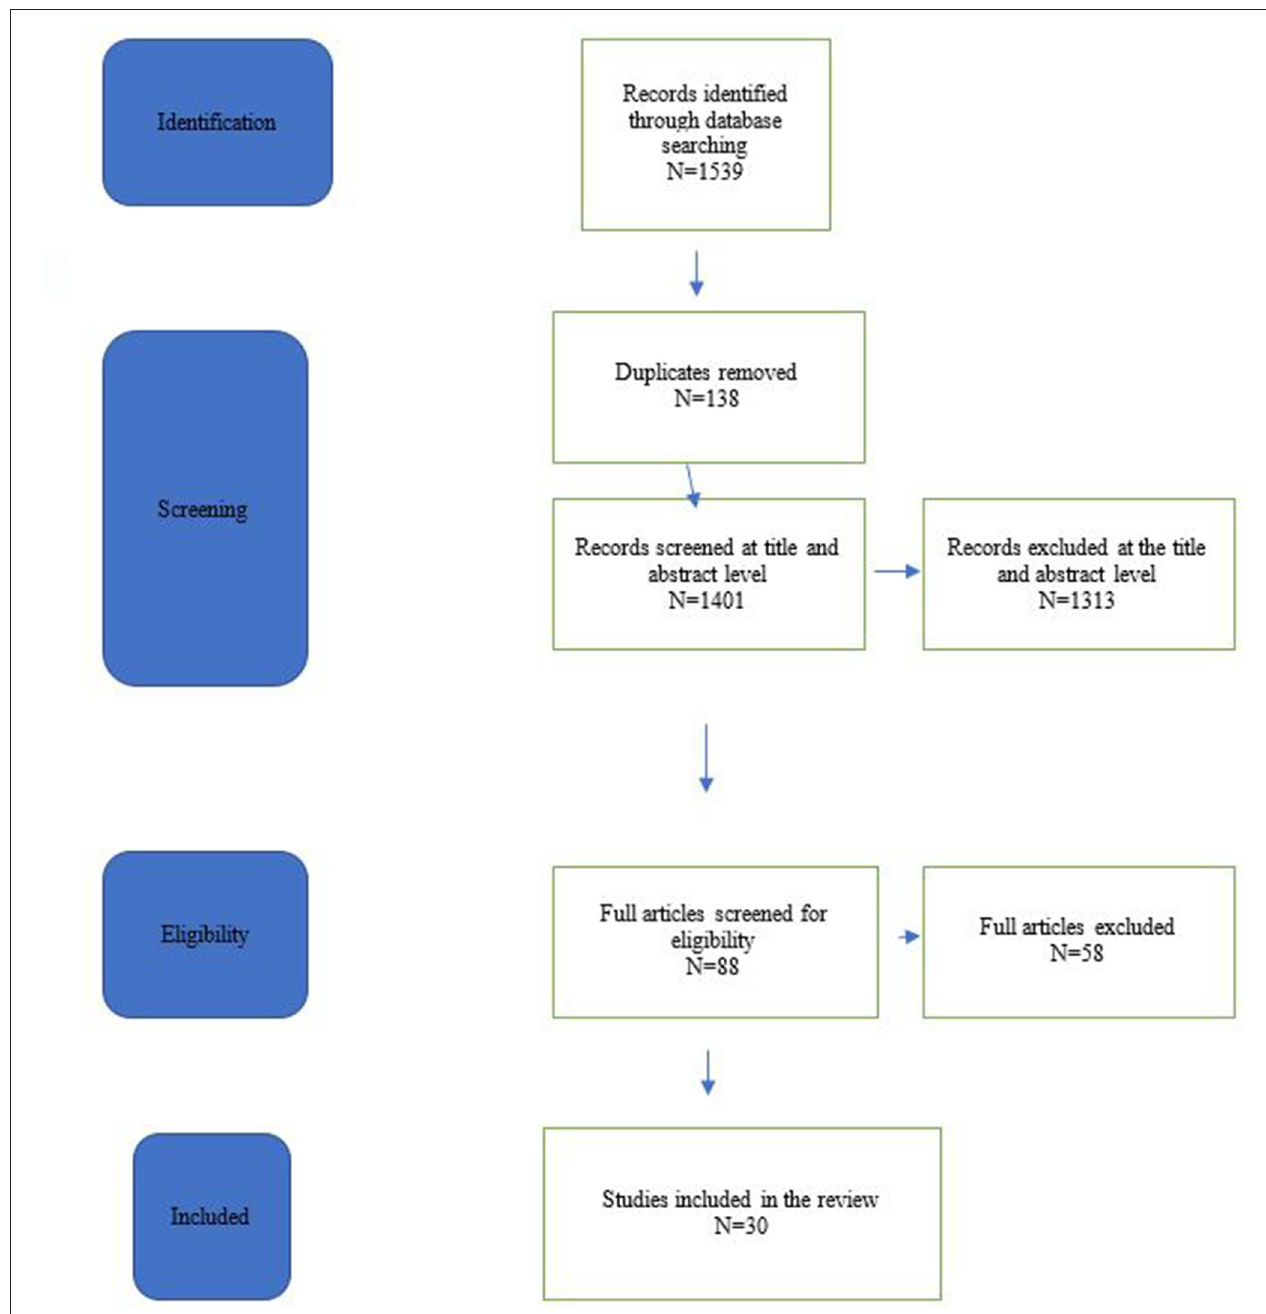
FIGURE 1 | Prisma